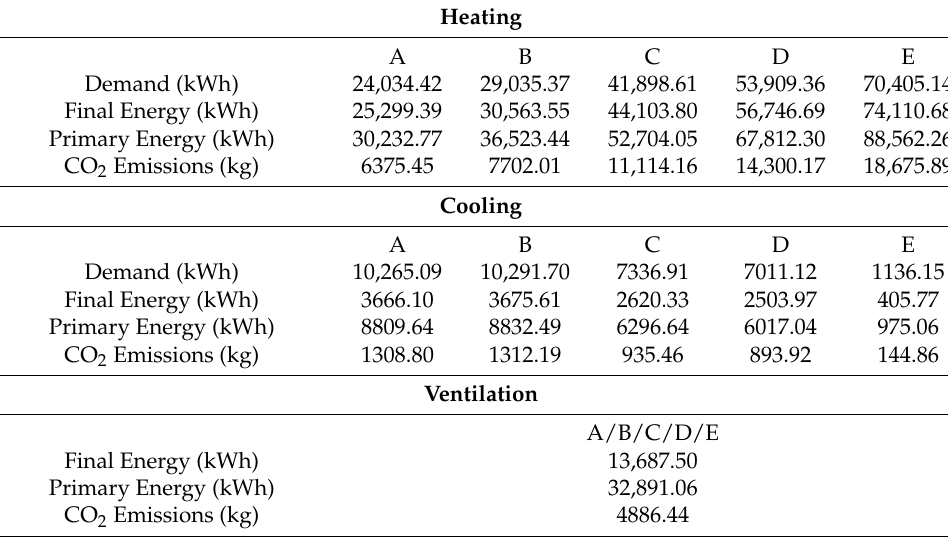
Table 9. Results Obtained with Regulation by